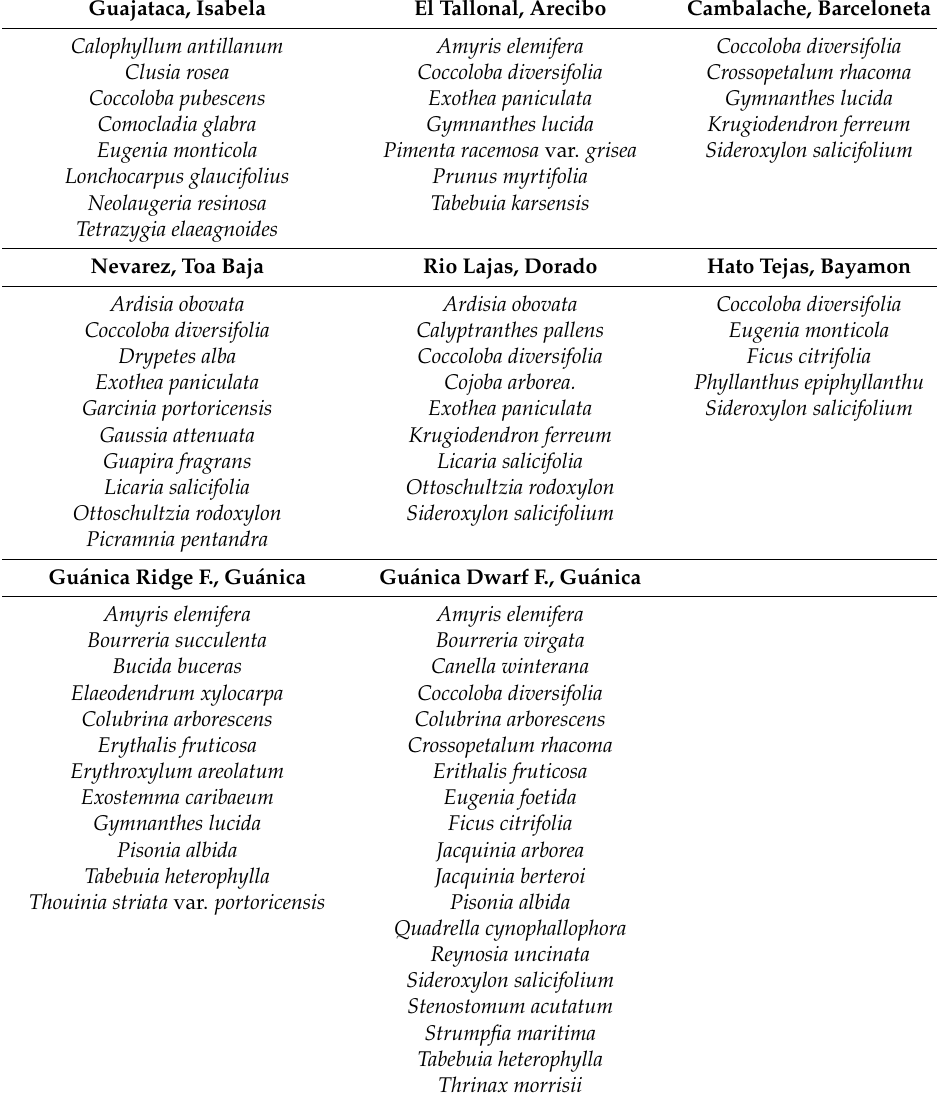
Table 2. Species sampled at each site designated by name and